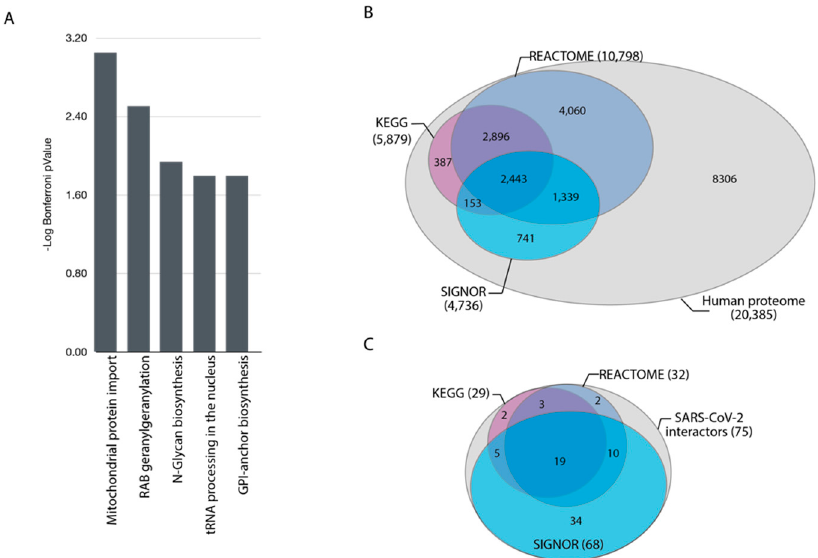
Figure 1. Functional analysis of severe acute respiratory syndrome coronavirus 2 (SARS-CoV-2) interactome. ( A ) ClueGO analysis of pathways enriched in the list of 75 cellular interactors of viral proteins. ( B ) Venn diagram representing the proteome coverage of the proteins annotated in the Reactome, KEGG and SIGNOR 2.0 databases. ( C ) Venn diagram illustrating the fraction of cellular partners of SARS-CoV-2 proteins ligands that are annotated in the three databases.